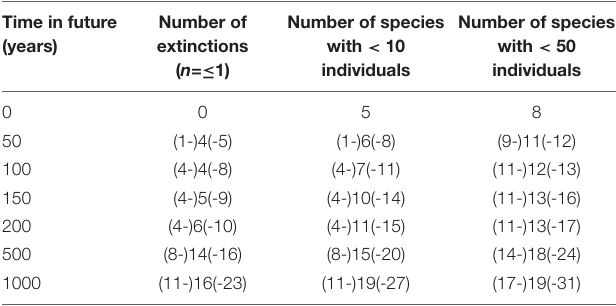
FIGURE 1 | Graph of census populations (number of mature individuals, log scale) of the endemic flora of St Helena ( Table 2 ), as a quantile-quantile (QQ) plot, showing the variation in absolute population sizes of the endemic plants.